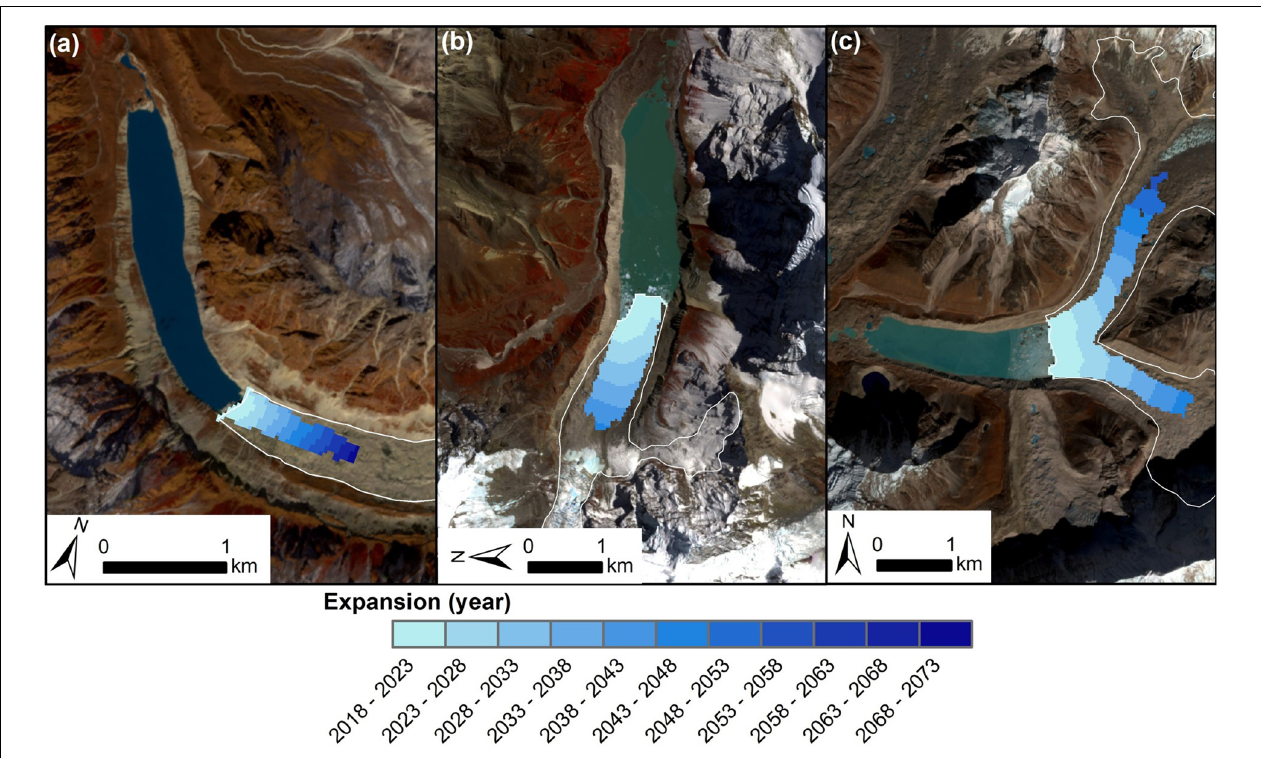
FIGURE 9 | Projected glacial lake expansion for (a) Thulagi, (b) Lower Barun and (c) Imja, using mean expansion rates (2008–2019) (Haritashya et al., 2018) and modelled ice thickness data (Farinotti et al., 2019). Colour bands are 5-year intervals. Background: Sentinel-2 Nir, red, blue composites from